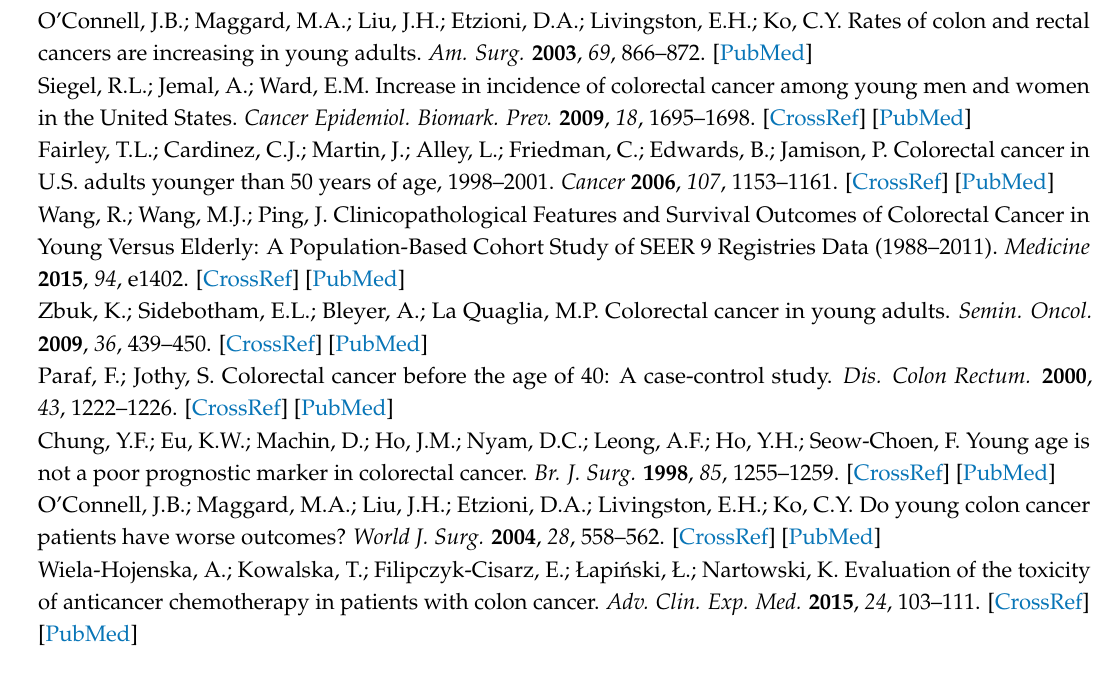
s1. Figure S1: CRC stages and distribution by age group, Figure S2: Predicted probabilities for age groups by CRC histology type, Figure S3: Adjusted Predicted probabilities of metastatic disease by age for EraA and EraB, Table S1: Hazard ratios (HR) of all-cause and CRC specific mortality in different age groups stratify by